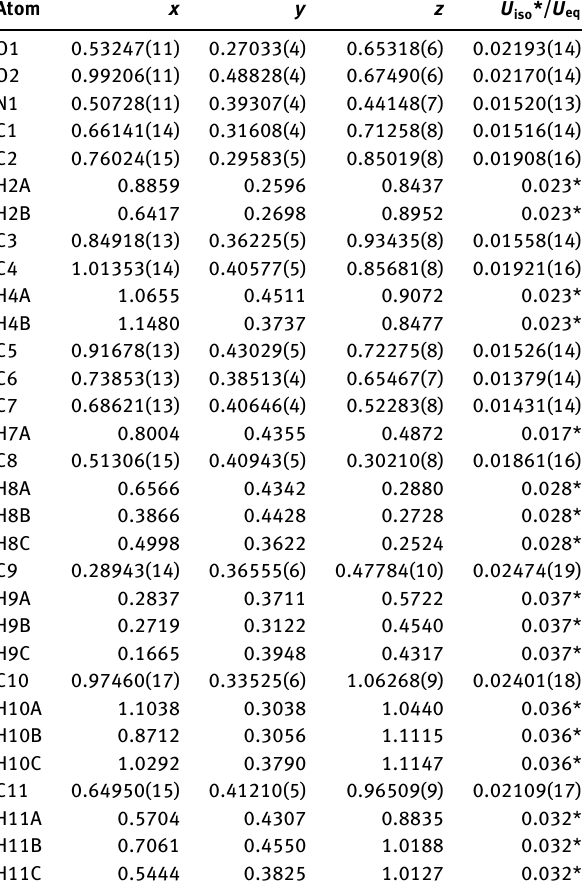
Table 2: Fractional atomic coordinates and isotropic or equivalent isotropic displacement parameters (Å 2